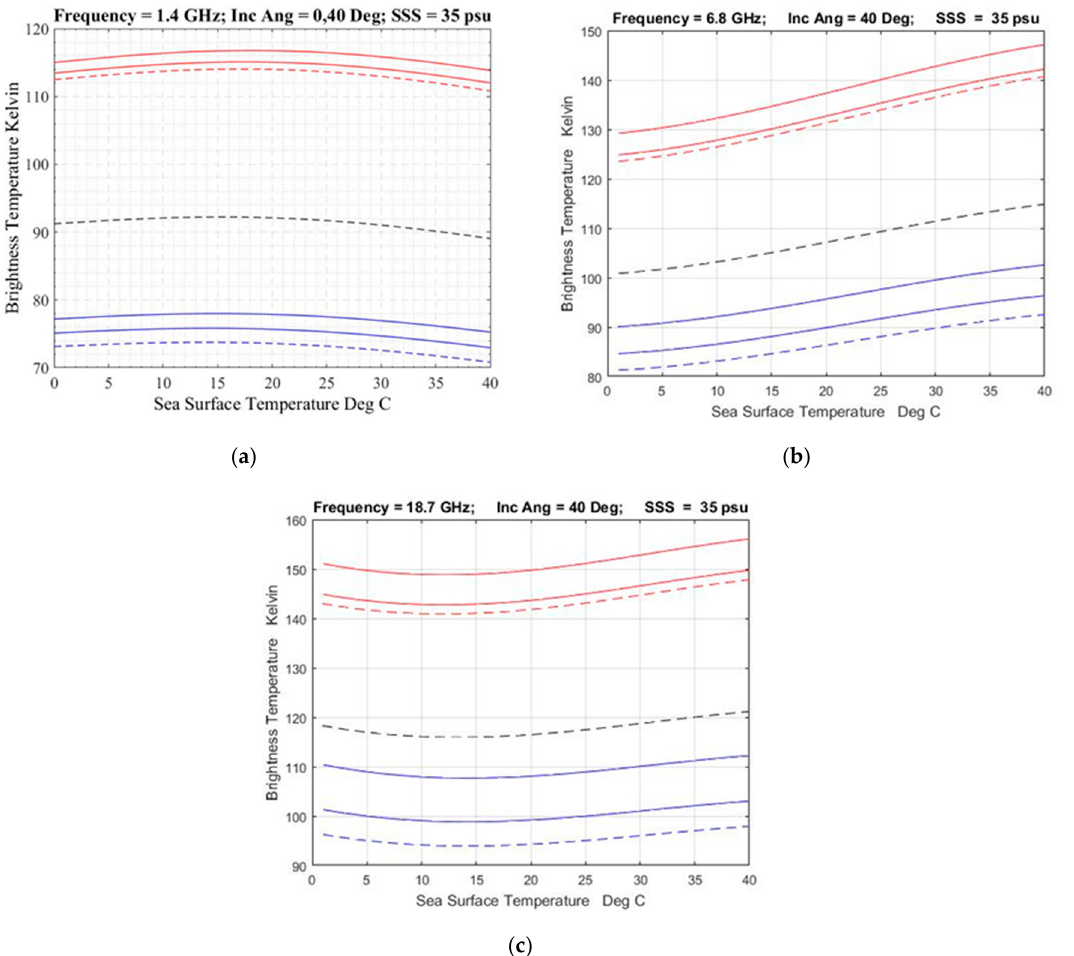
Figure 10. Brightness temperature vs. SST for constant wind speed at: ( a ) 1.4 GHz; ( b ) 6.8 GHz; ( c ) 18.7 GHz. The dashed curves are for 0 m / s. Black dashed is at nadir, red is vertical polarization and blue is horizontal polarization at 40 ◦ incidence angle. The solid curves are for WS = 7 and 14 m/s.